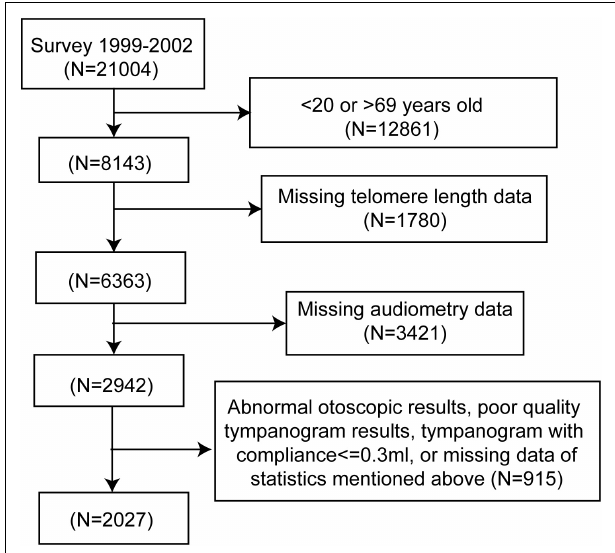
FIGURE 1 | Flow chart of the selection process. NHANES, National Health and Nutrition Examination